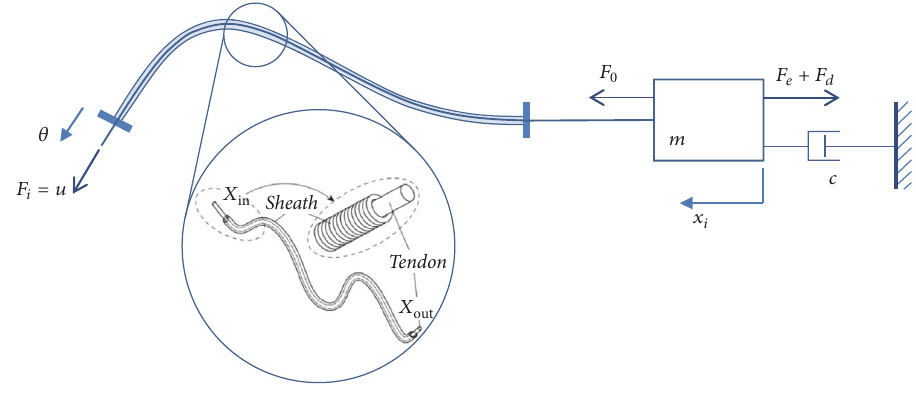
Figure 7: Force transmission on a